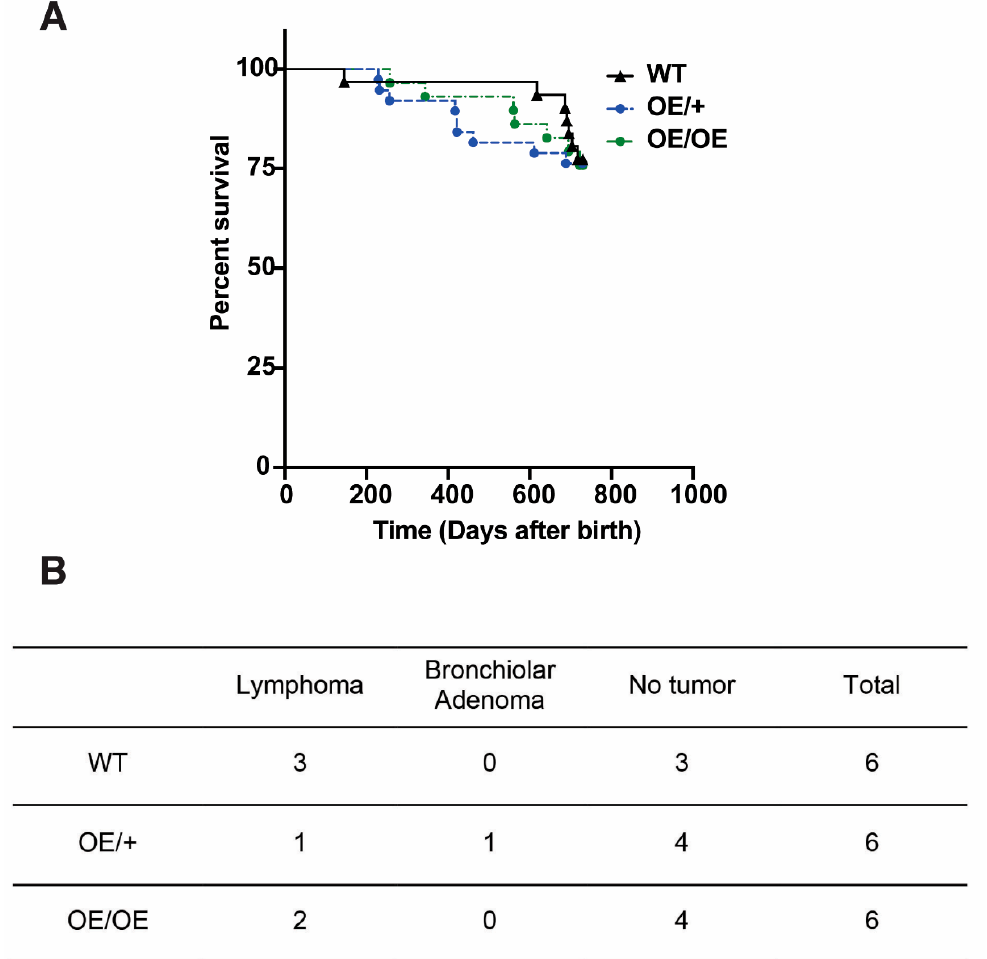
Figure 5. ( A ) Free survival of adult mice of wild type, Usp22 OE/+ or Usp22 OE/OE shows no significant differences between the different cohorts observed. ( B ) Necropsy results of 6 total 2+ year-old mice per genotype show no increased incidence of tumors in the OE/OE homozygotes or OE/+ heterozygotes compared to their wild type littermates.